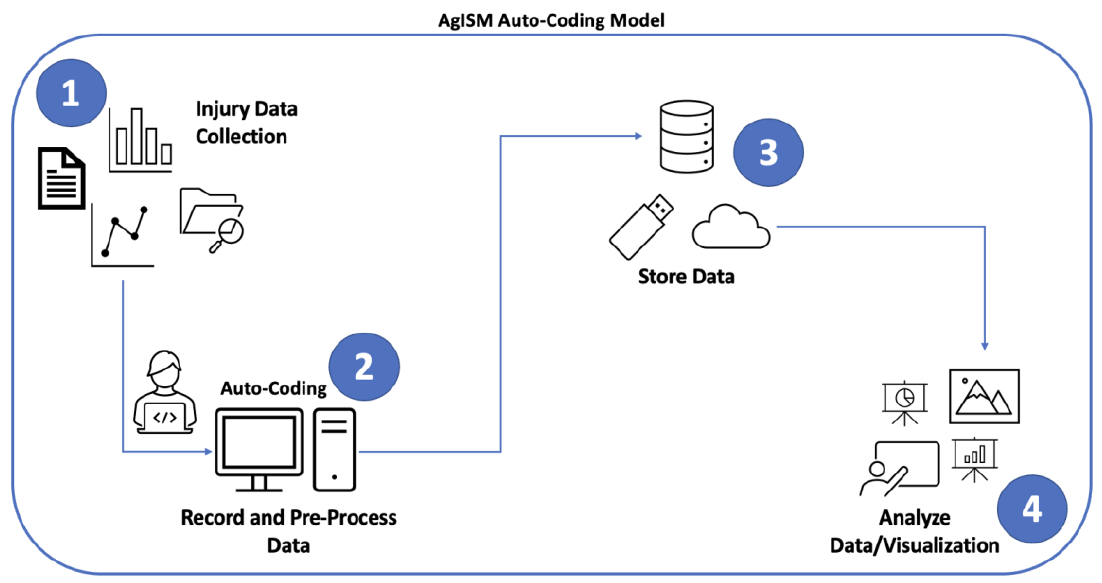
Figure 1. Overview of the validation process of AgISM model.